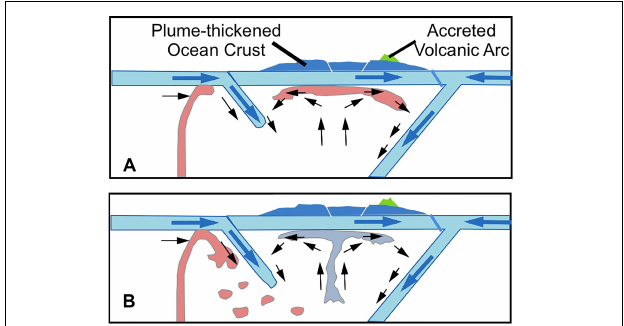
FIGURE 10 | MTZ partial alternative to a Galapagos Hot Spot model for CLIP as applied to damp 64 Ma komatiites. (A) Panel from the model of Loewen et al. (2013) at 70–60 Ma. In their model, the need to have plume mantle between the subduction zones is explained by the isolation of existing CMB-derived plume head (pink) between the two subducting oceanic slabs (blue with blue arrows). If, however, evidence for a link between most of the CLIP and a core-mantle boundary plume is established beyond dispute, then this finding would not negate the potential for a big wedge plume (light blue) to generate the Gorgona komatiites, as shown in (B)